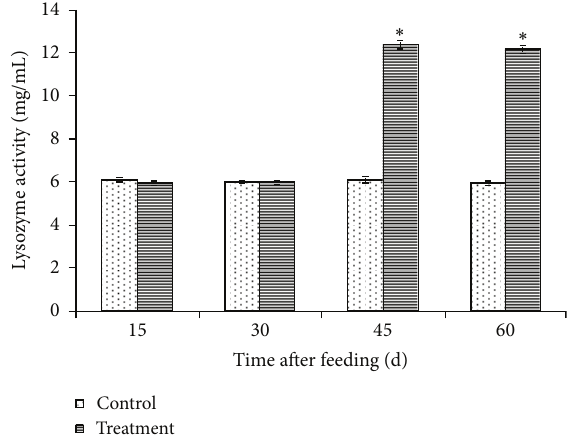
Figure 2: Lysozyme activity in hybrid catfish fed diets with (treat- mentgroup)andwithout(controlgroup) L.plantarum C014.Results were presented as means ± SD of triplicate observations. Significant differences ( 𝑃 < 0.05 ) from the control group of the same day are indicated by